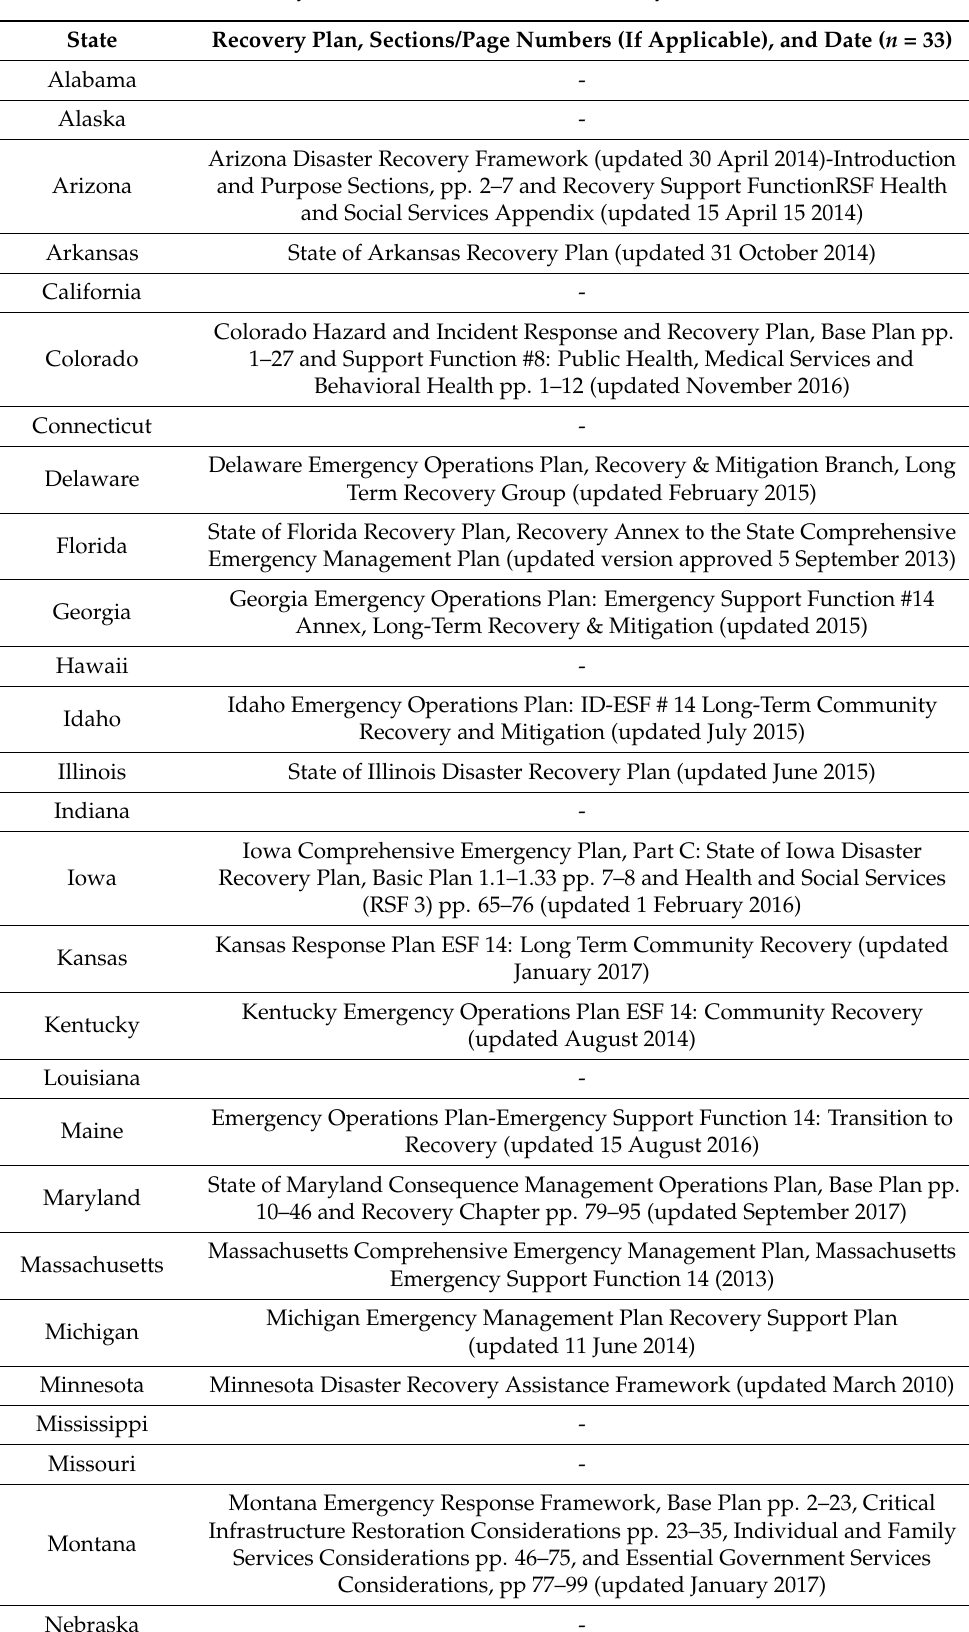
Table 1. State Disaster Recovery Plans Identified and Sections